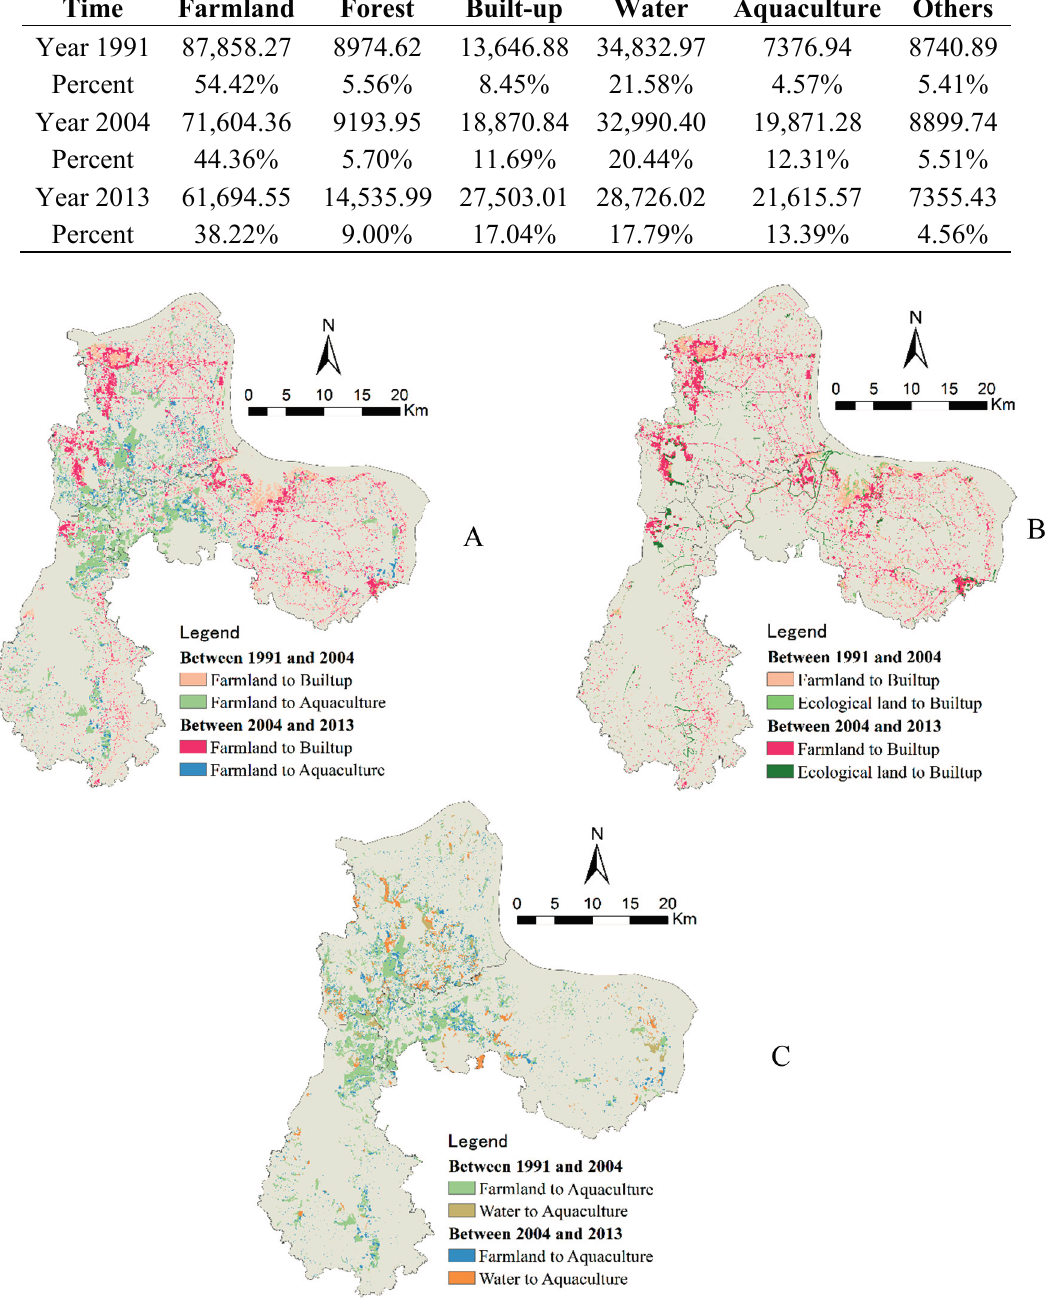
Figure 5. Spatial patterns of land conversion (( A ) conversion from farmlands; ( B ) conversion to built-up; ( C ) conversion to